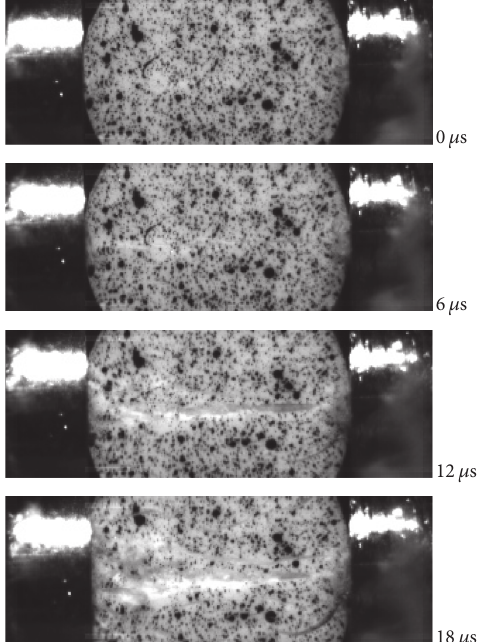
Figure 6: Sequence of the high speed video acquired during dynamic test at 175000 fps at a resolution of 320 × 104 pixels: the crack is visible starting from the second image (specimen ID